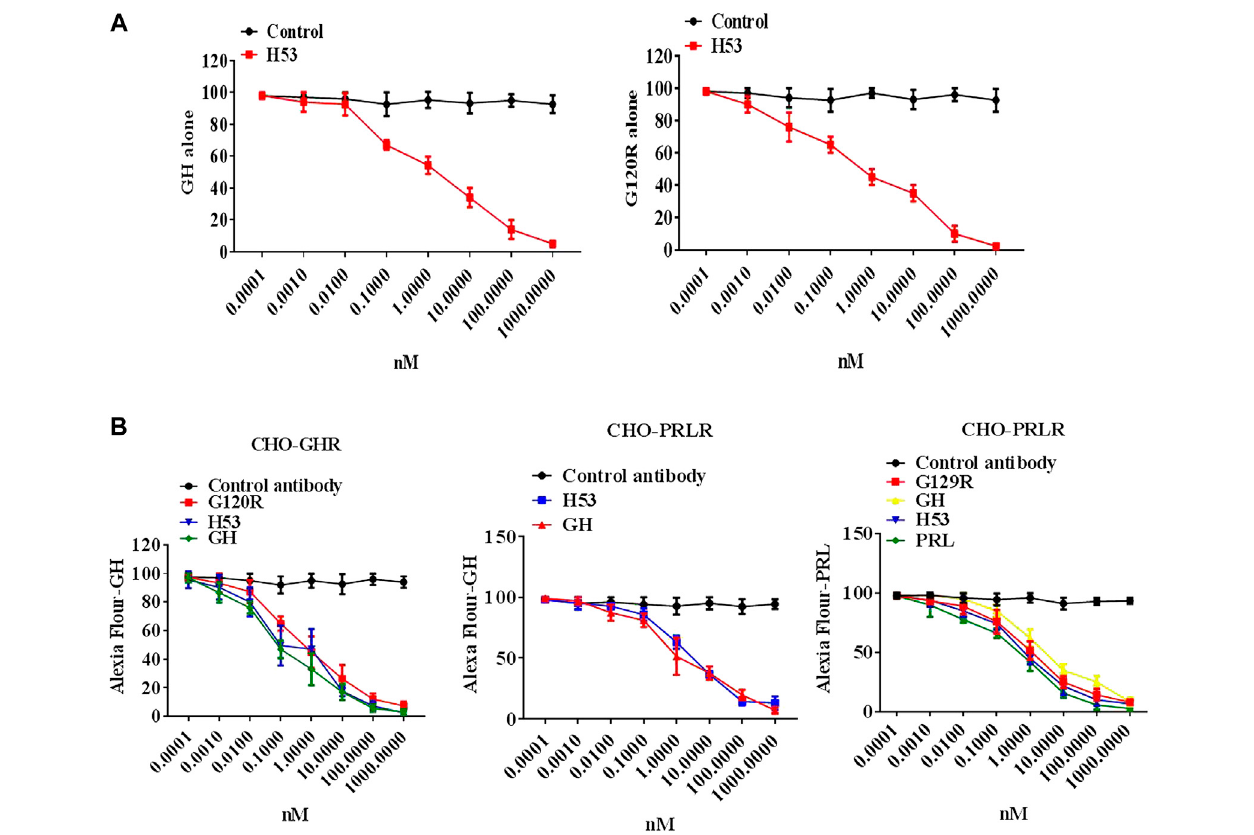
FIGURE 3 | (A) H53 competed with GH/G120R to bind to GHR. ELISA plate was coated with the extracellular domain of GHR (GHR-ECD), and then GH alone or GH was mixed with increasing concentrations of F(ab ’ ) 2 of H53 or F(ab ′ ) 2 of control antibody. Next, the mixtures were added to each well of the ELISA plate. (B) H53 inhibited GH/PRL binding to GHR/PRLR as determined by the competitive receptor binding assay. The experimental process has been described in detail in the materials and methods section. The cell samples were examined using a Becton-Dickinson FACS Calibur Flow Cytometer; Data are shown as the mean ± SD of three independent